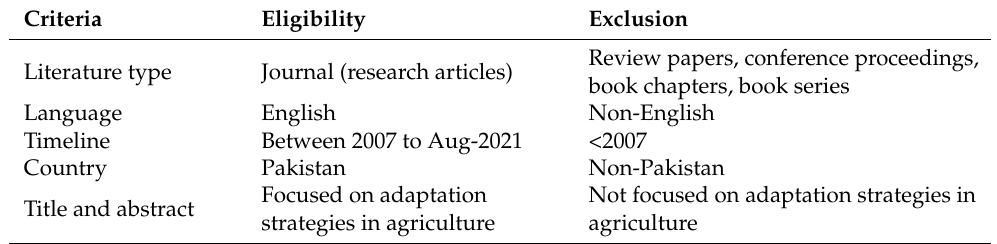
Table 2. Inclusion and exclusion criteria.